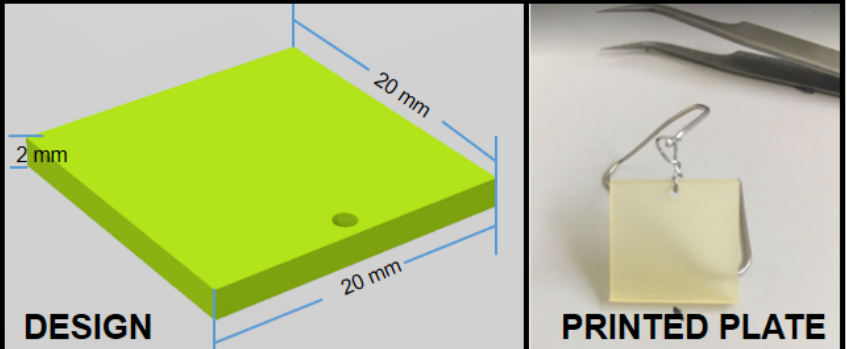
Figure 14. Three-dimensonally-printed plates for the analysis of post-treatment and coating strate- gies.